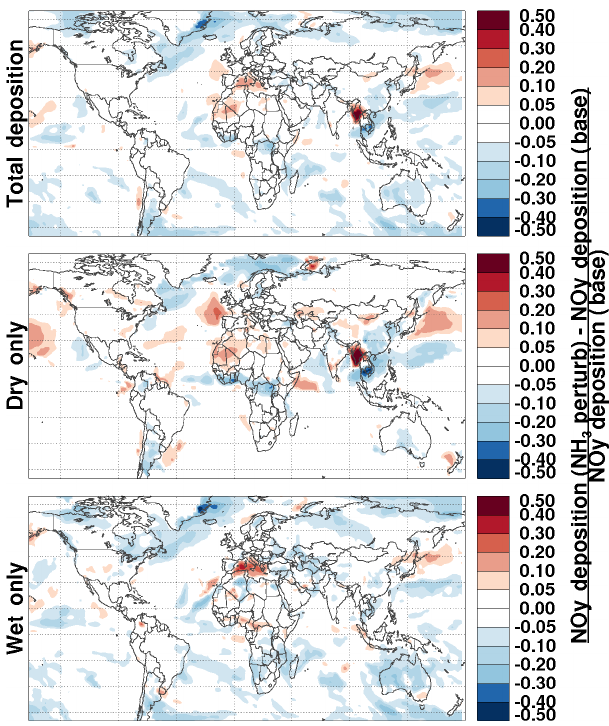
Figure 8. Sensitivity of simulated NO y deposition in 2012 to a 25% perturbation (increase) in ammonia emissions in all grid boxes (shown separately for total deposition, dry deposition, and wet de-